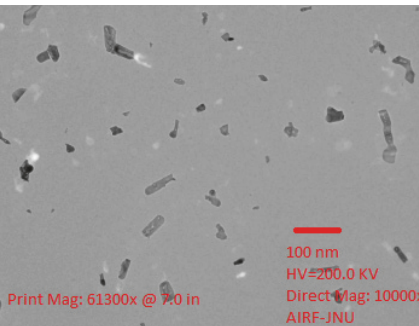
Figure 7: Standard graph between response current and substrate